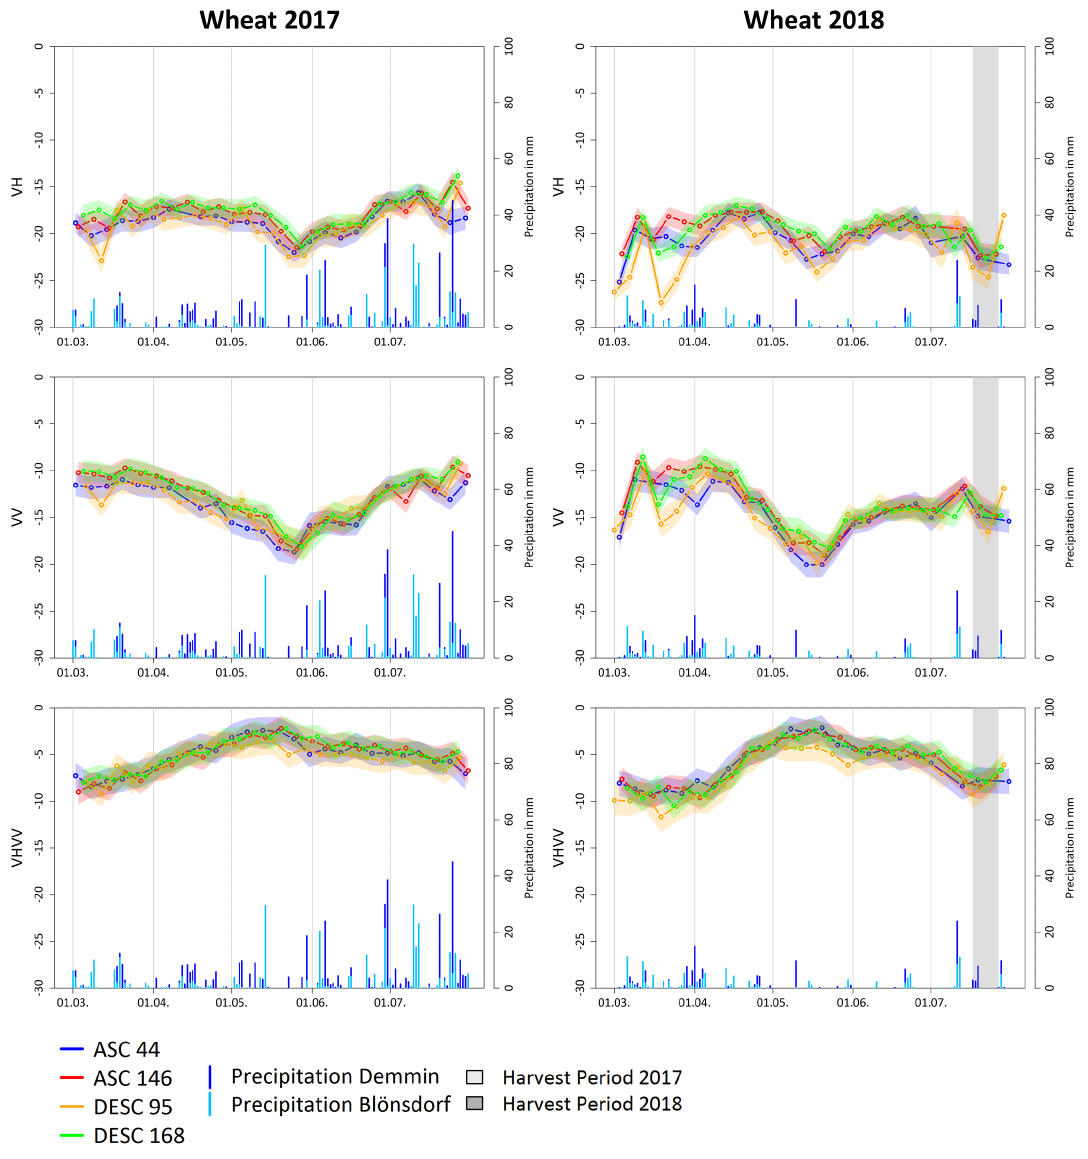
Figure 5. Temporal profiles of backscatter parameters VV, VH and VH/VV of wheat fields in 2017 ( left ) and 2018 ( right ). Standard deviations are depicted as polygons around lines. Blue bars represent daily precipitation sums for the test sites Demmin (dark blue) and Blönsdorf (light